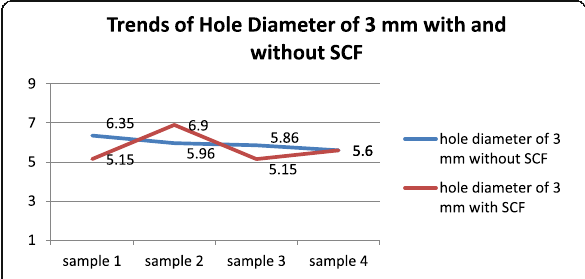
Fig. 11 Graphical Representation of Hole diameter of 3 mm Glass Pane with and without SCF